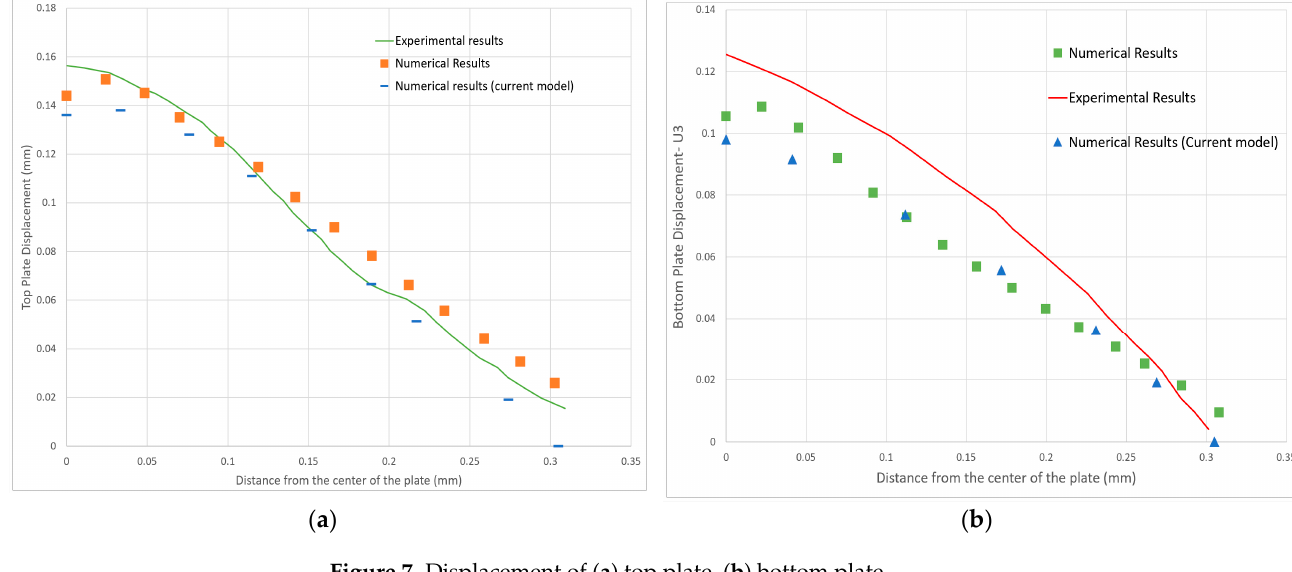
Figure 7. Displacement of ( a ) top plate, ( b ) bottom plate.